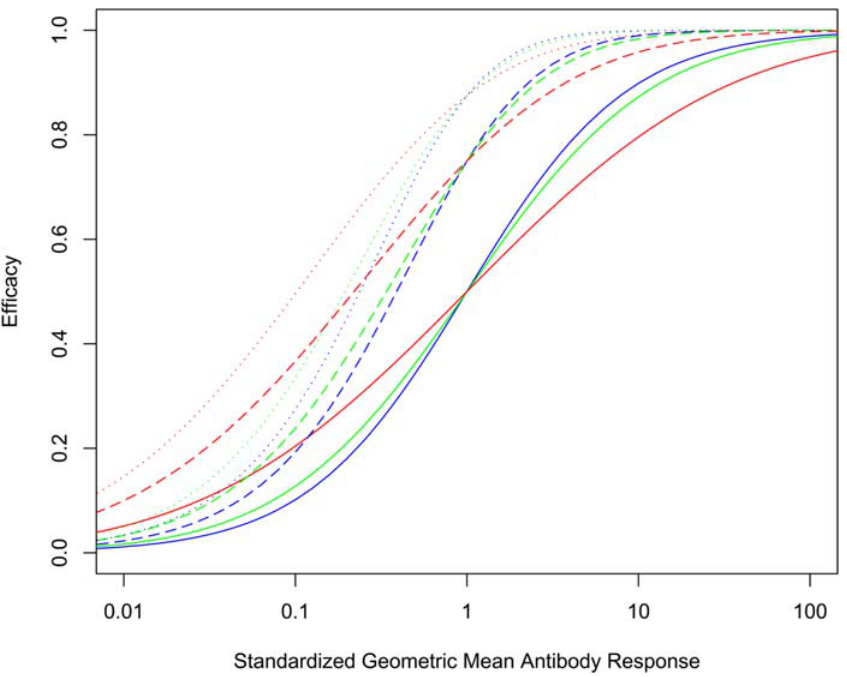
Figure 2. Model prediction for the efficacy of single component vaccines (solid line), two component vaccines (dashed lines) and three component vaccines (dotted lines) as a function of the mean immune response elicited in the population to each component. This data set assumes that each component contributes equally to the efficacy, the immune responses to the individual immunogens are not correlated and that the log transformed distribution of the immune response is normal with a fold range of 9 (blue), 65 (green) and 5,000